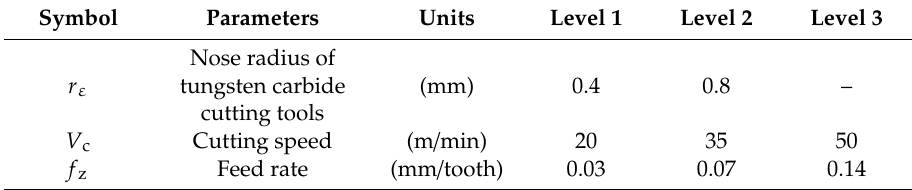
Table 4. Cutting tool and machining parameters used in the milling process.